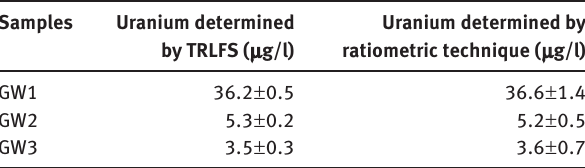
Table 2 Total uranium concentrations in the groundwater samples taken from the KURT determined by TRLFS and ratiometric techniques.